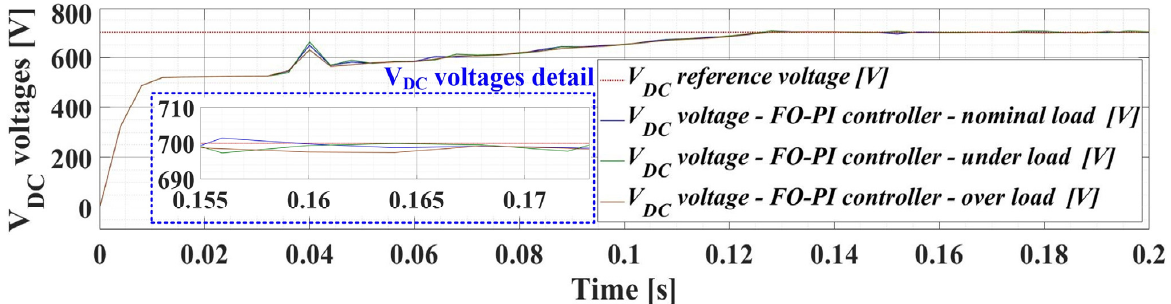
Figure 9. V DC voltages time evolution of the UPQC-APF control system based on PI-GWO controller in case of nonlinear load.